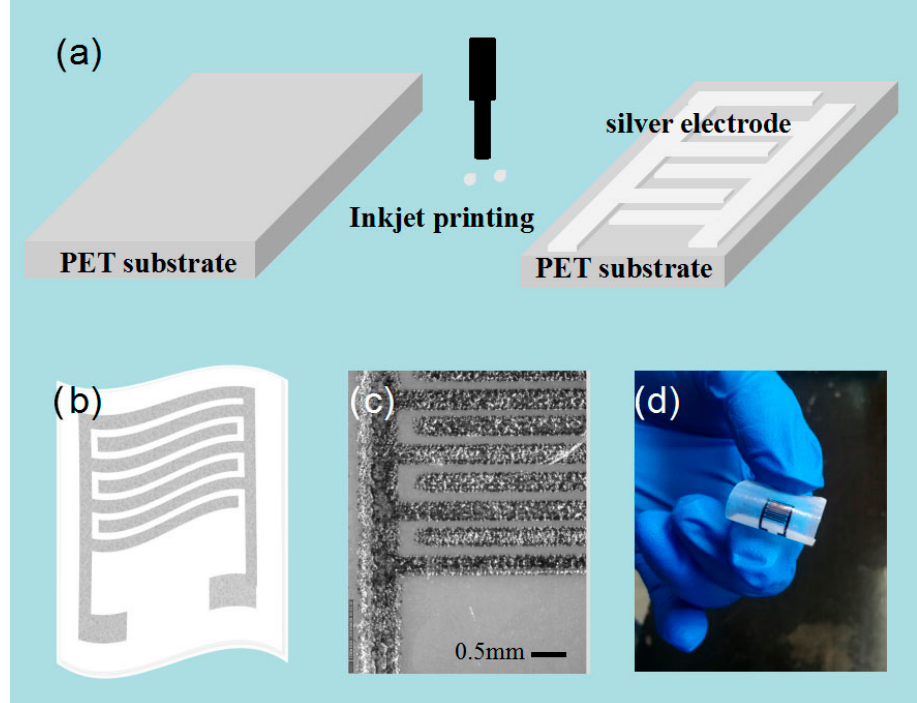
Figure 1. The fabrication process of Ag electrodes. ( a ) Schematic illustration of inkjet printing; ( b ) schematic diagram of flexible electrodes; ( c ) photograph of processed electrodes; ( d ) photograph of flexible substrate.